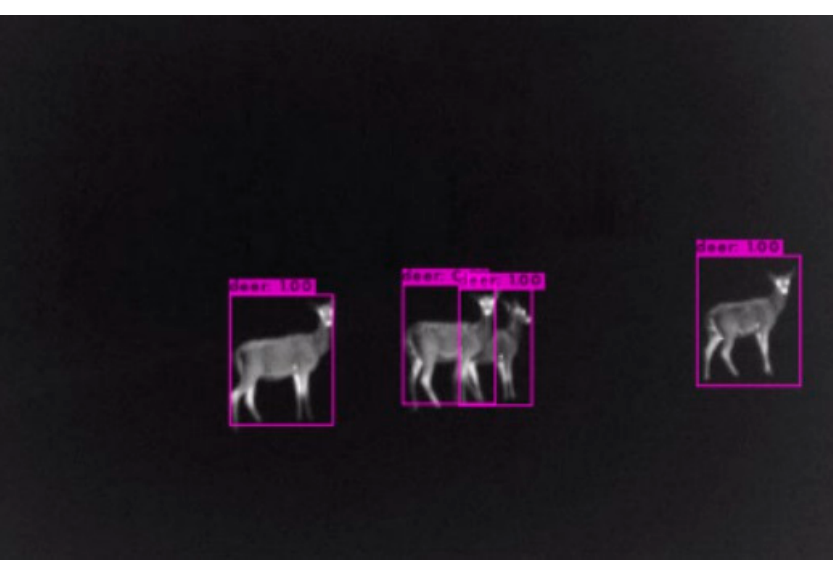
Figure 4. Detection result for YOLOv3 with the specified probability of the given class .